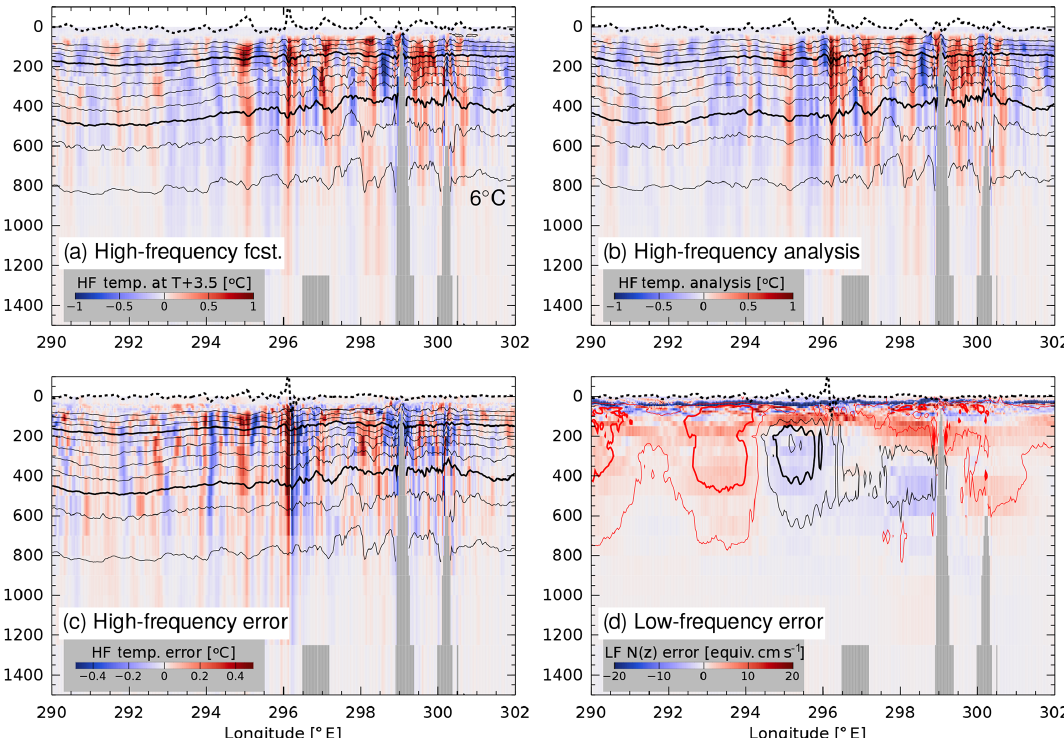
Figure 7. Zonal transect of temperature at 13 . 7 ◦ N (cf. Fig. 5). (a) The high-frequency (HF) temperature forecast and (b) the HF verifying analysis, both valid at T + 3 . 5 = 4 January 2013 at 12:00:00Z. The solid contours indicate the total temperature field (2 ◦ C contour interval). The dashed line at the top, centered on z = 0, is the HF steric height in units of millimeters (the maximum at x = 296 ◦ E is almost η (cid:48) = 10cm). This transect cuts slightly north of the shallow seamount, Aves Ridge, which rises to within about 600m of the ocean surface at 13 . 4 ◦ N, 297 ◦ E. Here, the topography is represented by the gray shading visible near 297, 299, and 300 ◦ E. (c) The HF forecast temperature error (color scale) and steric height error (dashed line centered at z = 0) are largely associated with a slight shift in the location of the wave at 296 . 1 ◦ E. (d) Error in the low-frequency (LF) forecast is represented with error in buoyancy frequency, N(z) , which is multiplied here by 200m to scale it like mode-1 baroclinic wave phase speed (based on the Wentzel–Kramers–Brillouin (WKB) approximation, c 1 = N(z) d z , about 3ms − 1 ). Contours represent LF temperature error (0 . 5 ◦ C contour interval, positive in black, negative in red) with π − 1 R 0 − H thicker contours at + 0 . 75 and − 0 . 75 ◦